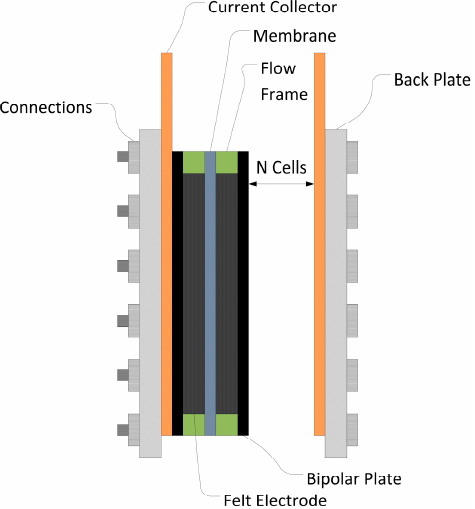
Figure 1. Components and layout of a redox flow battery stack (after [9]).